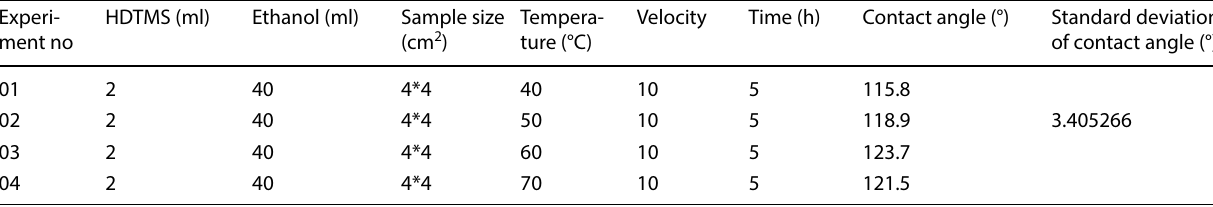
Table 4 Different contact angle for different temperature using same